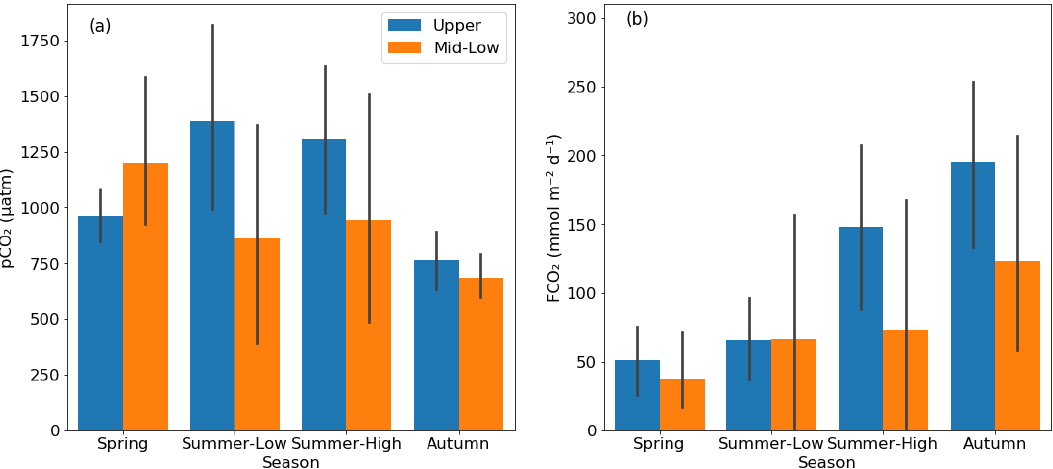
Figure 3. The bar charts showing the pCO 2 ( a ) and FCO 2 ( b ) pattern in different seasons between the upper reaches and the middle-lower reaches in rivers. The grey error bars show the range of 95% confidence interval.